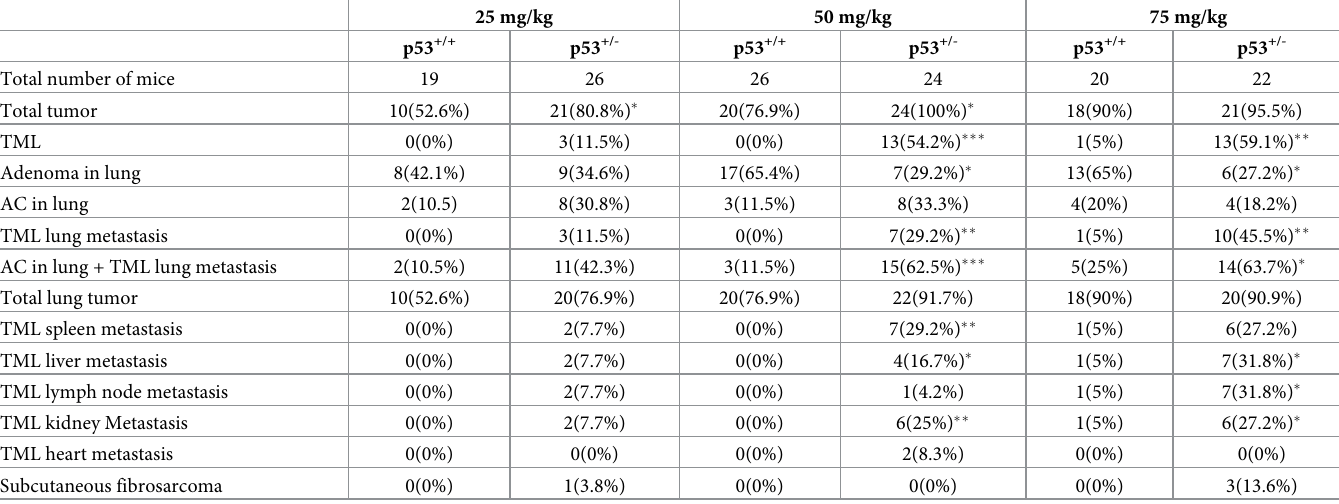
Table 1. The number of tumors observed in each organ after MNU administration in different